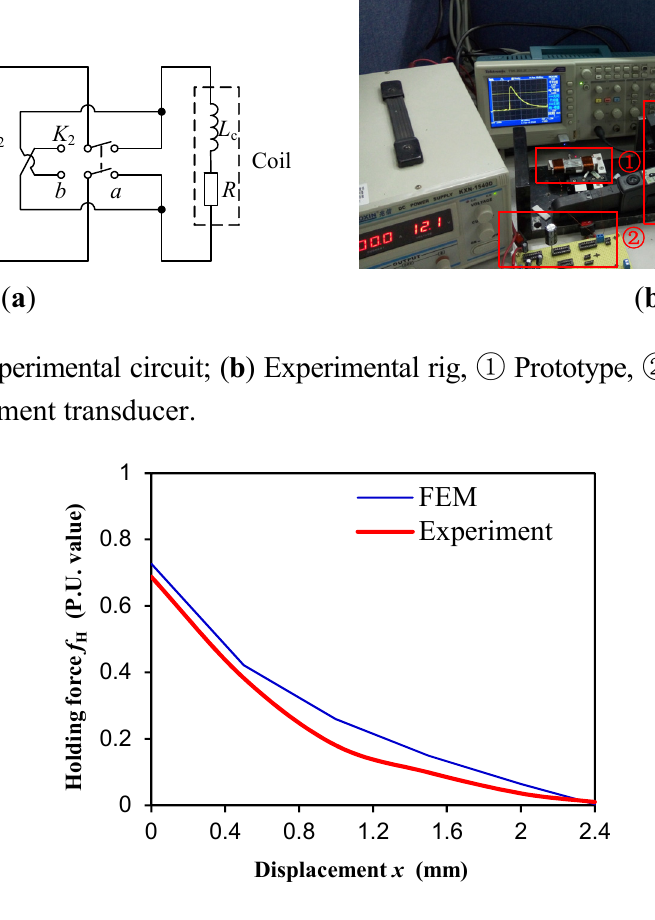
Figure 12. Comparison of the holding force at different